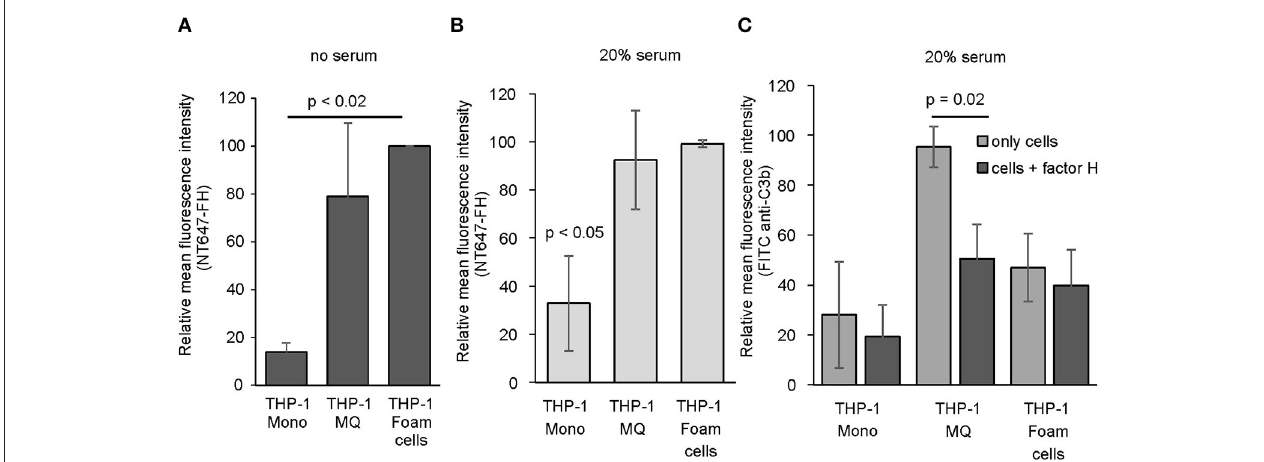
FIGURE 4 | Binding of FH and C3b deposition on THP-1 cells. Binding of NT647-labeled FH to THP-1 monocytes, THP-1 macrophages and cholesterol-loaded THP-1 macrophages (foam cells) in the (A) absence ( n = 3) or (B) presence ( n = 3) of 20% serum. (C) Deposition of serum C3b on THP-1 monocytes, THP-1 macrophages and THP-1 foam cells in the presence or absence of FH ( n = 3). Statistical significance was calculated using using one-way ANOVA supplemented with Tamhane’s post-hoc multiple comparison test. Error bars indicate SD. Percentages of mean fluorescence intensities are shown as relative to the maximum intensity in each individual